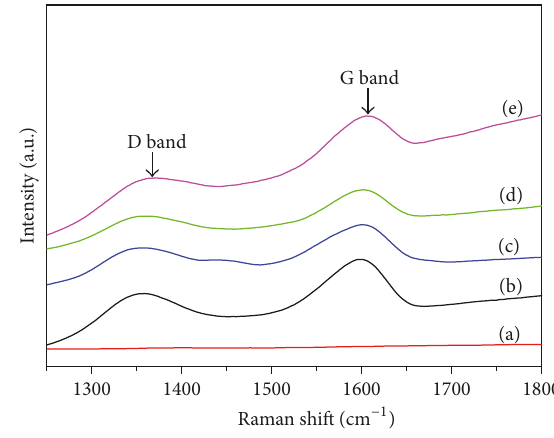
Figure 2: Raman spectra of PNIPAM/KGM (a), GO (b), PNIPAM/ KGM/GO1 (c), PNIPAM/KGM/GO2 (d), and PNIPAM/KGM/GO3 (e) composite membranes.